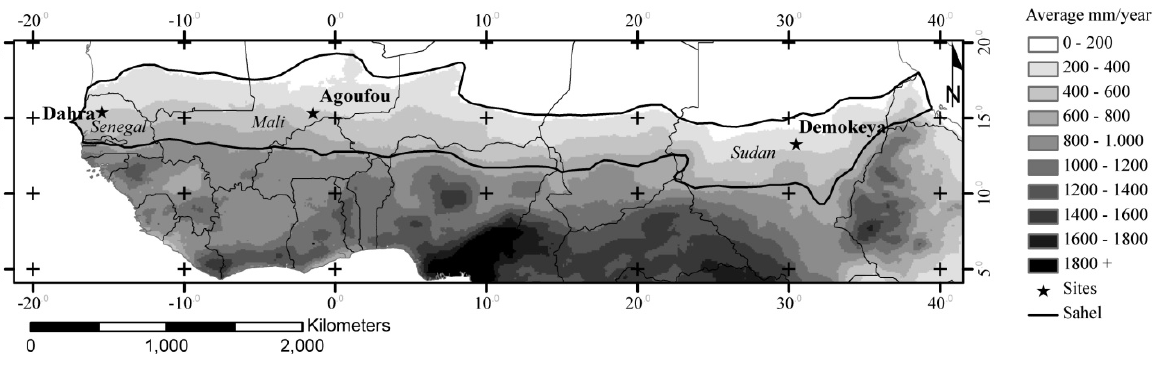
Figure 1. Locations of test sites (black stars) in semi-arid Sahel and average annual rainfall from 2001 to 2012 calculated from CPC RFE v2 is shown in 200 mm